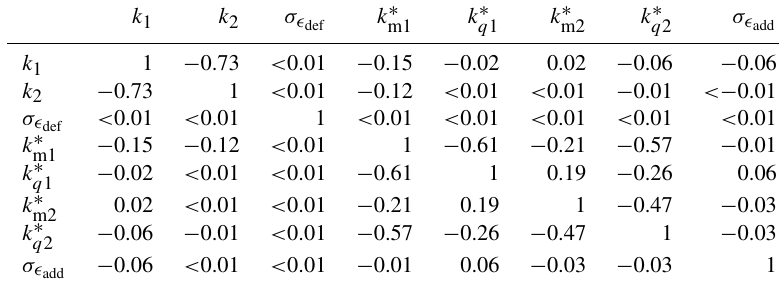
Table 5. Correlation coefficients between model parameters estimated using Bayesian inference. k